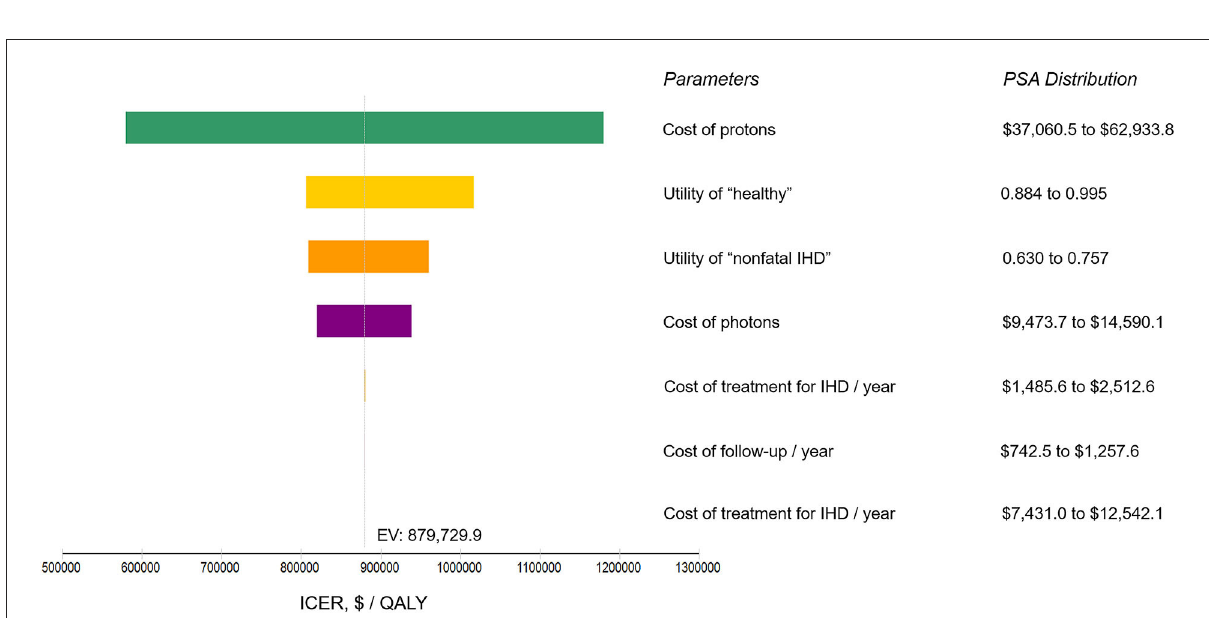
FIGURE3 Tornado diagram analysis using the baseline set-ups. Illustrating the range of incremental cost-effectiveness ratio (ICER) when varying each parameter individually over a range of their 90% confidence interval identified in probabilistic sensitivity analysis (PSA). Influential parameters are listed in descending order according to their abilities in affecting the ICER. IHD, ischemic heart disease; $, US dollars; QALY, quality-adjusted life-year; EV, expected